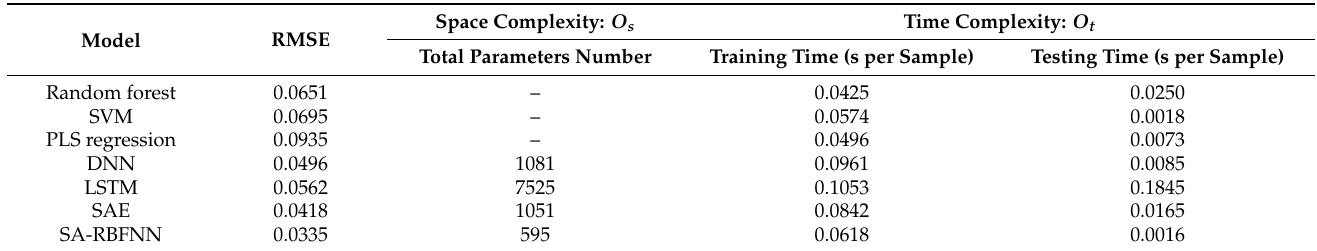
Table 4. Comparison results of space and time complexity for different models on testing